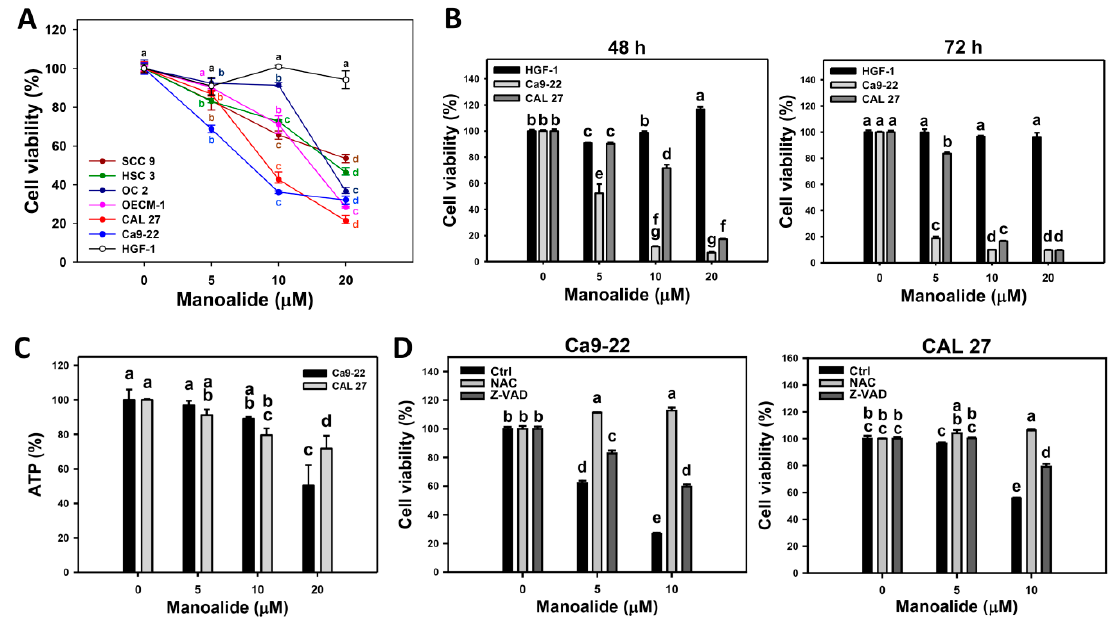
Figure 1. Cell viabilities of oral cancer cells after manoalide treatment and its N -acetylcysteine (NAC)/ apoptosis inhibitor Z-VAD-FMK (Z-VAD) e ff ects. Cells were treated with 0, 5, 10, and 20 µ M of manoalide. All treatments have the same concentration of DMSO. ( A ) MTS assay-based cell viabilities for 24 h. Oral cancer (CAL 27, Ca9-22, OECM-1, OC-2, HSC 3, and SCC9) cells and oral normal (HGF-1) cells were included. ( B ) MTS assay-based cell viabilities for 48 and 72 h for oral cancer (CAL 27 and Ca9-22) and oral normal (HGF-1) cells. ( C ) Statistical of 3D spheroid formation for manoalide-treated oral cancer (Ca9-22 and CAL 27) cells for 72 h. ( D ) NAC and Z-VAD e ff ects on MTS viability of manoalide-treated oral cancer cells. Pretreatment conditions were 8 mM, 1 h for NAC and 100 µ M, 2 h for Z-VAD. Following pretreatment or not, oral cancer (Ca9-22 and CAL 27) cells were post-incubated with 5 and 10 µ M manoalide for 24 h. Data, means ± SDs ( n = 3). Data were analyzed by one-way ANOVA with Tukey HSD Post Hoc Test. Data showing the same small lettersrepresent nonsignificant di ff erences whereas data showing no overlapping same small letters are significant di ff erence ( p < 0.05–0.001).